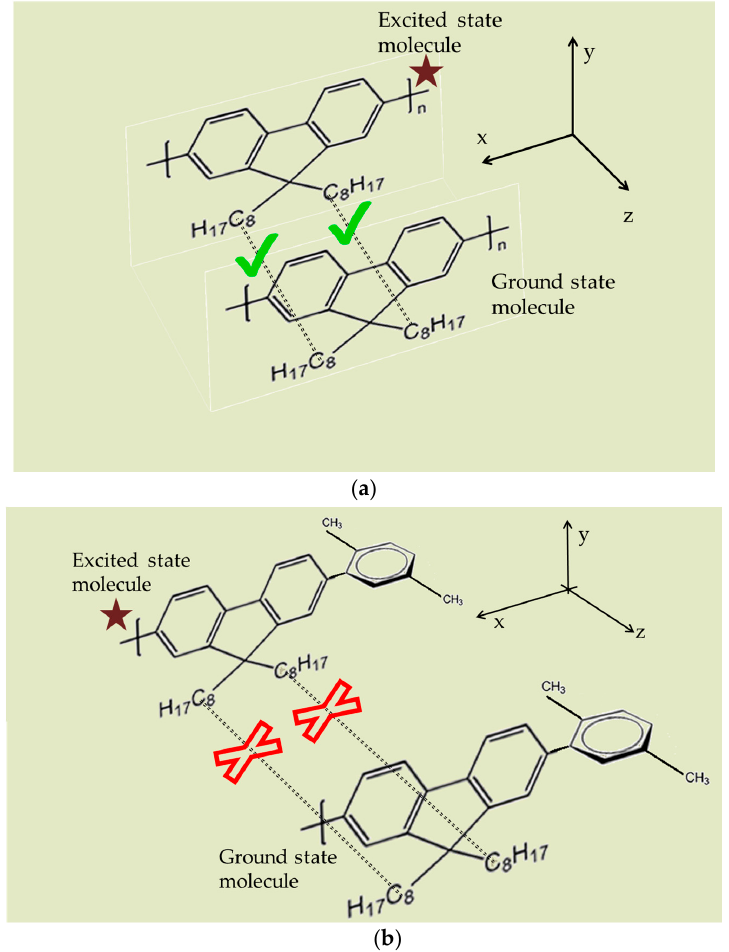
Figure 10. The plausible mechanism of formation ( a ) excimer in case of PFO alone; ( b ) the absence of any aggregation such as excimer in the case of PFO-co-pX—the pX segment forbids excimers by orienting in the XZ plane and sterically hindering the excimer formations.